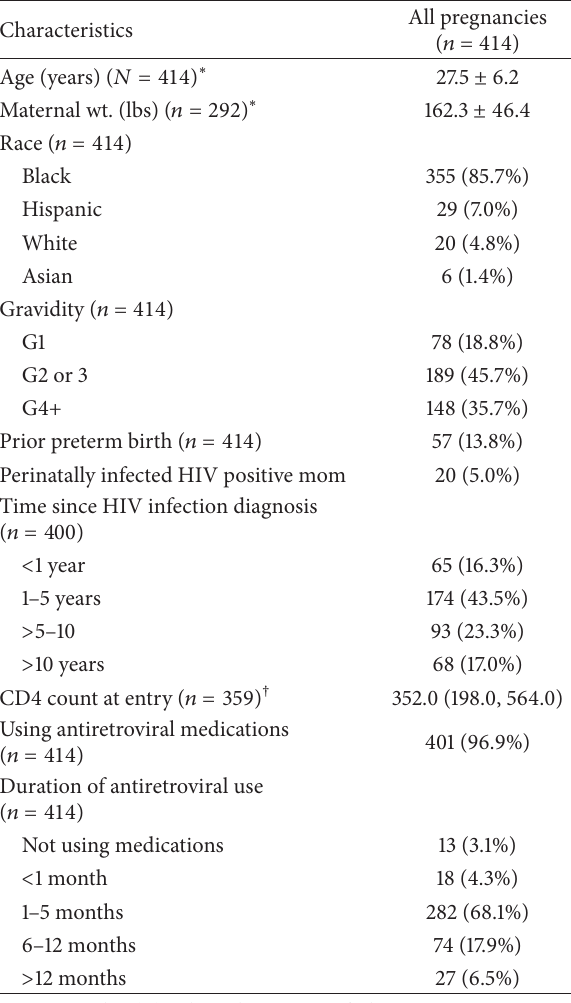
Table 2: Characteristics of HIV infected pregnancies with and without concomitant sexually transmitted